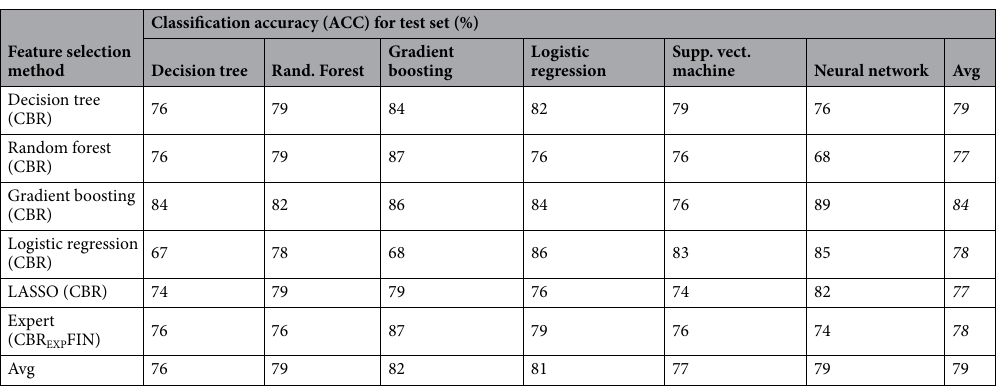
Classification accuracy (ACC) for test set (%) Feature selection method